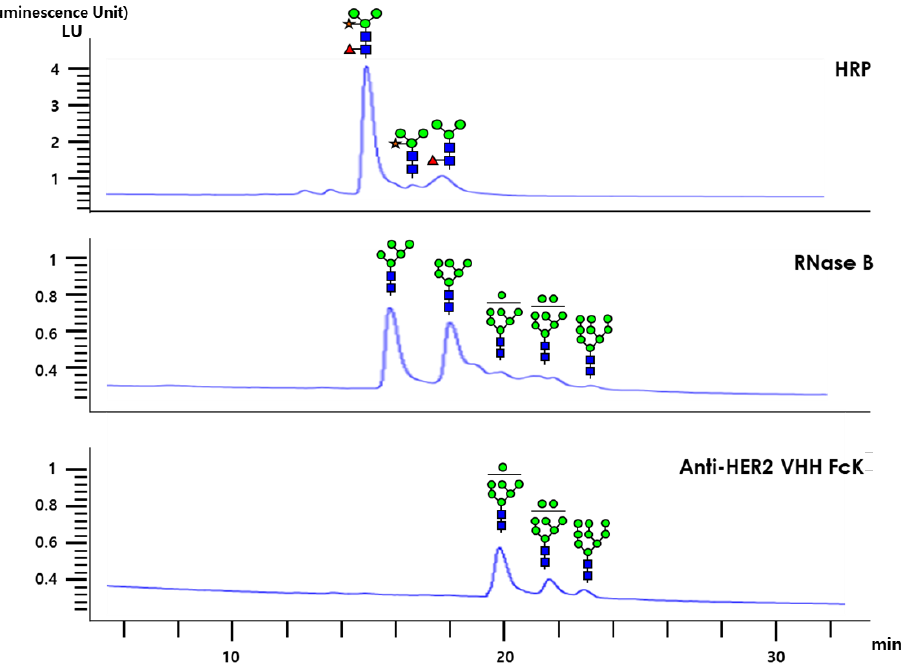
Figure 6. HPLC analysis for glycan structures of bovine pancreas-derived RNase B (RB), plant-derived HRP, and plant-derived anti-HER2 VHH-FcK. The specific glycan structures of different peaks are presented. GlcNAc, fucose, mannose, and xylose are depicted as blue squares, red triangles, green circles, and yellow stars, respectively.